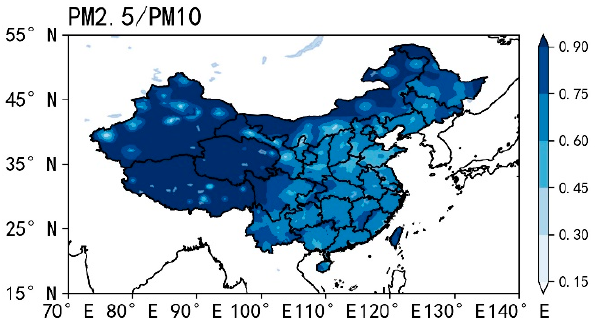
Figure 6. Interannual variation in the ratio of the PM 2.5 to PM 10 concentration in the Tarim Basin ( a ) and the North China Plain ( b ) in summer from 2013 to 2018 (orange lines represent the median, green triangles represent the mean value and black dots represent the discrete point).